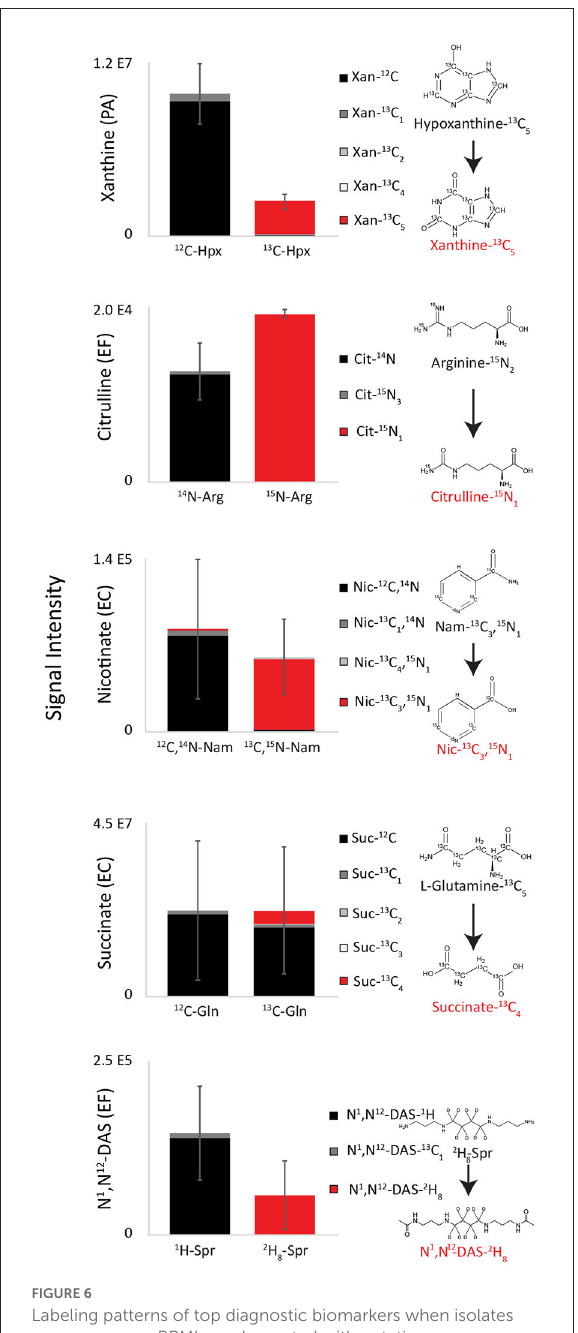
FIGURE6 Labeling patterns of top diagnostic biomarkers when isolates were grown on RPMI supplemented with putative precursors. Species-specific xanthine, citrulline, nicotinate, and N 1 ,N 12 -diacetylspermine were all > 95% labeled when labeled substrates were used, demonstrating that that hypoxanthine, arginine, nicotinamide, and spermine are direct medium precursors for xanthine, citrulline, nicotinate, and N 1 ,N 12 -diacetylspermine (Source Data File 6). EC cultured in RPMI with unlabeled glucose and uniformly labeled L-glutamine- 13 C 5 was 80% fully 12 C labeled and 15% fully 13 C 4 labeled, demonstrating that it is mostly synthesized from glucose, although glutamine partially contributes to its